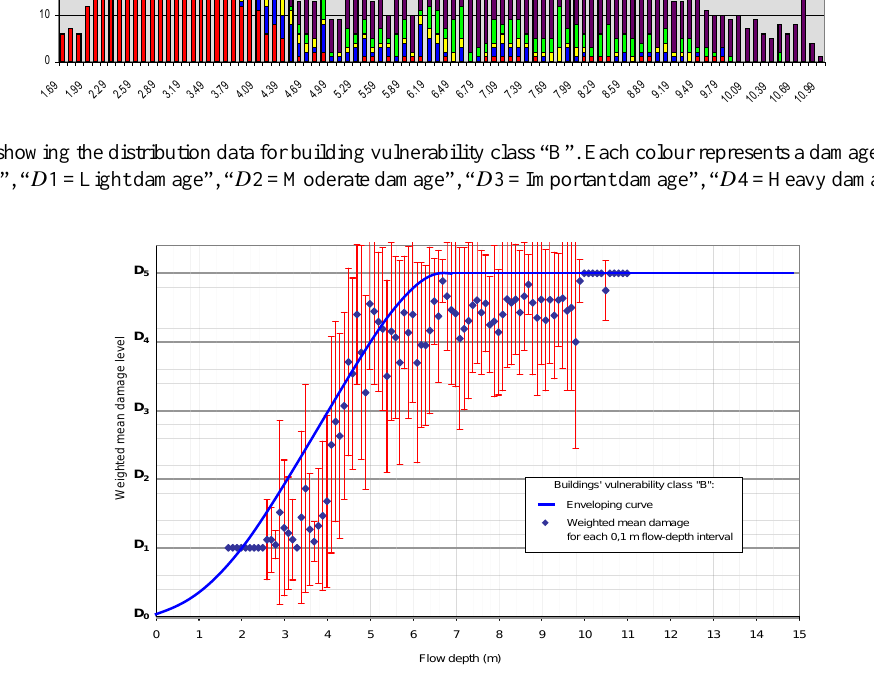
Fig. 6. Enveloping curve of the weighted mean damage level for building vulnerability class “B”. Standard deviation for mean damage level ¯ D i is shown with red